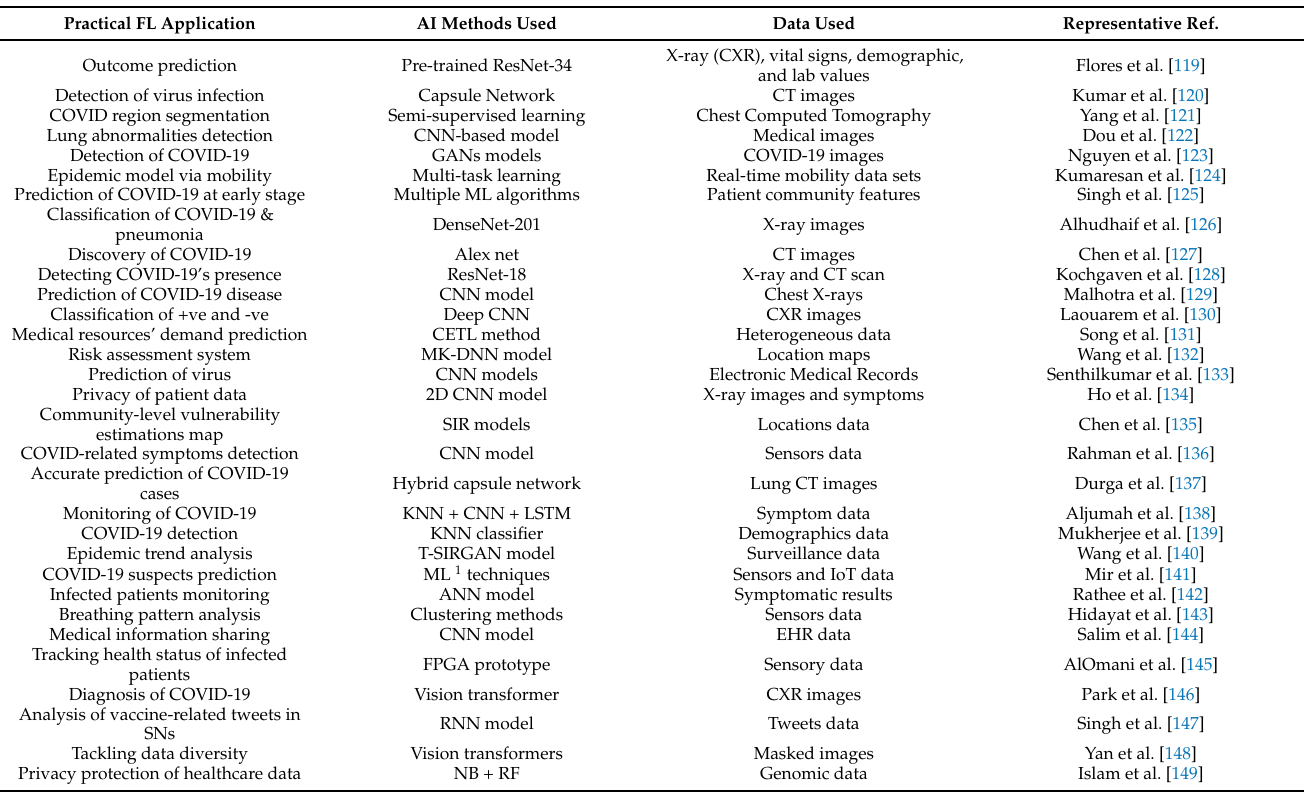
Table 4. Recently developed/proposed practical applications of FL in the context of